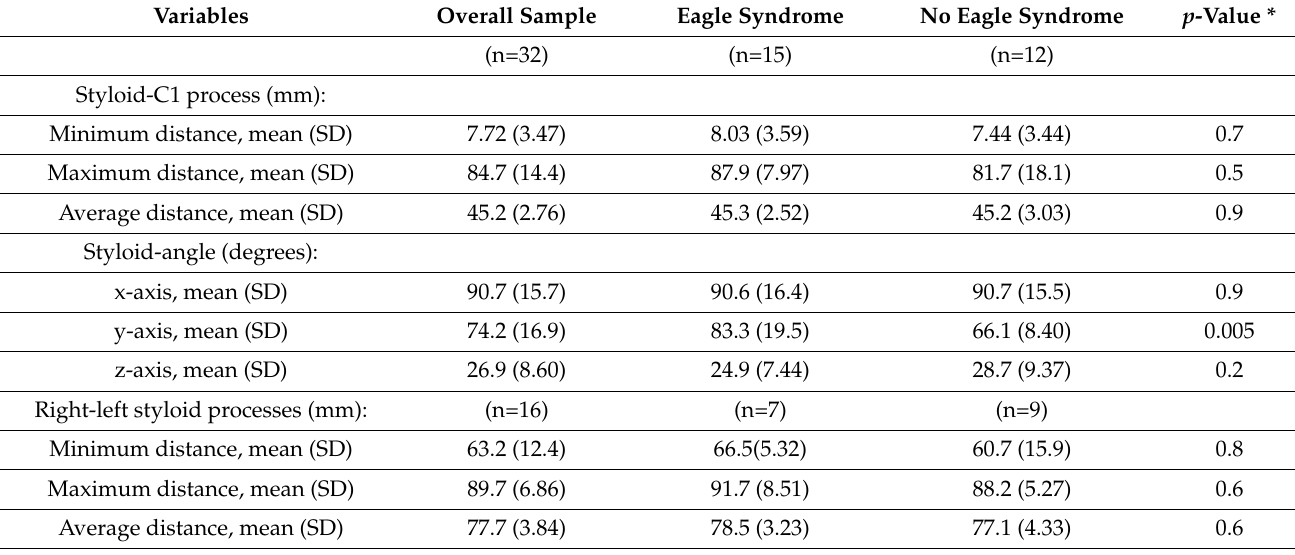
* Kruskal-Wallis test; SD: standard